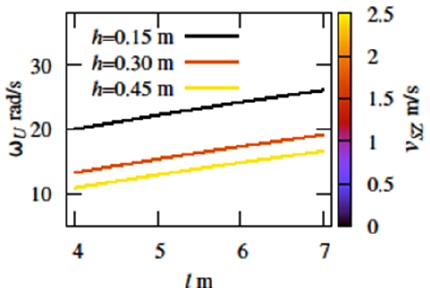
Figure 4. Upper arm angular velocity for the different ball release positions. Lower release shots have larger vertical shoulder speed at release. As horizontal shot distance increases, upper arm angular velocity also increases.